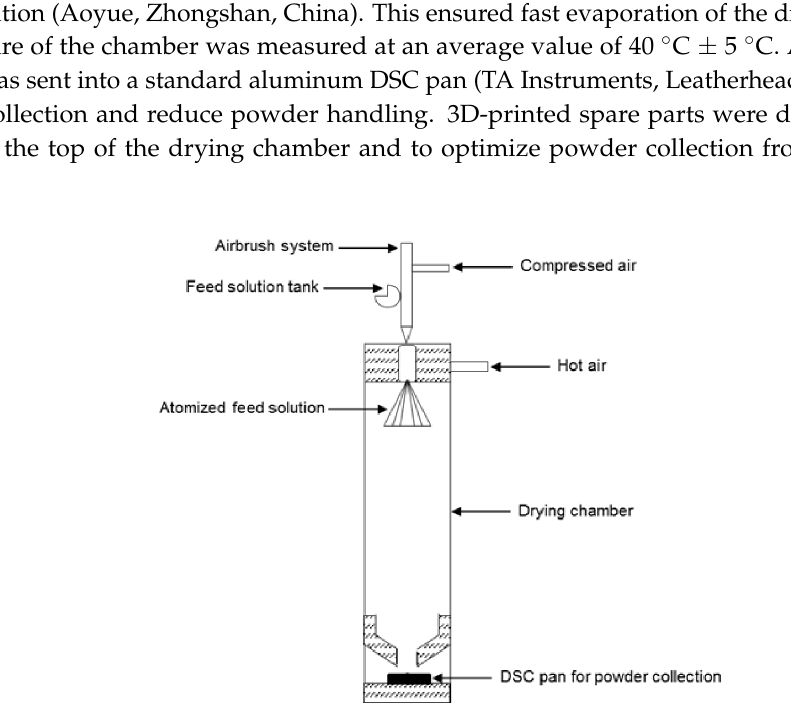
Figure 2. Schematic representation of atomization screening device. DSC: differential scanning calorimetry.